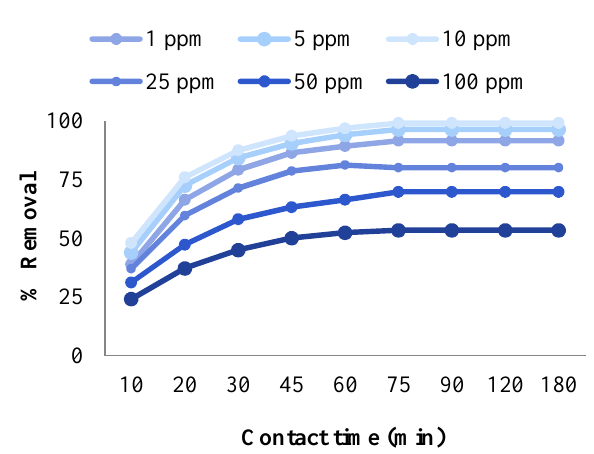
Figure 2. Effect of contact time and initial Cr (VI) concentration on removal efficiency (pH = 3, adsorbent dose = 5 g/L, temperature = 30 °C) Effect of pH